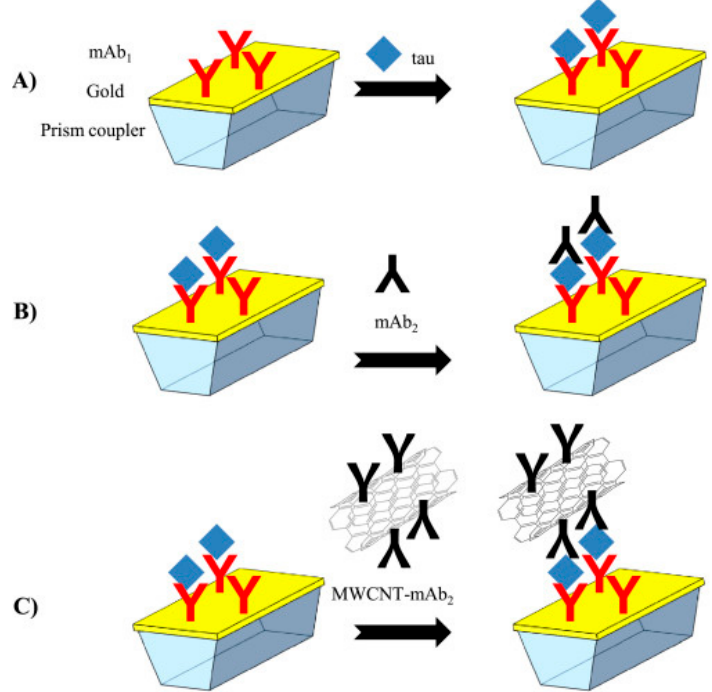
Figure 4. Design of surface plasmon resonance (SPR) assays for tau quantification: ( A ) direct approach; ( B ) sandwich assay; ( C ) sandwich assay with secondary antibodies coupled with multi-walled carbon nanotubes (MWCNTs) (Reproduced with permission from [47]. Elsevier, 2017).